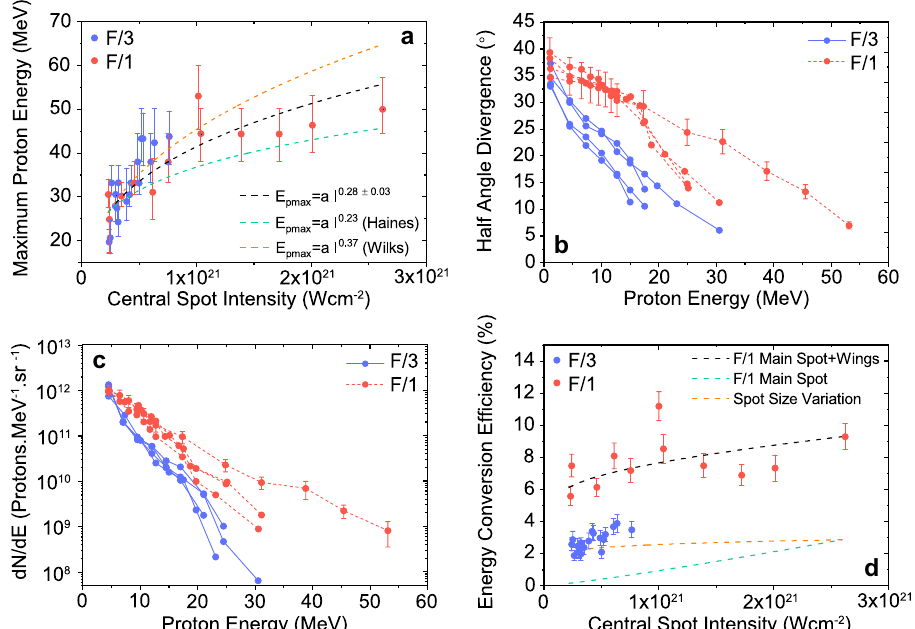
Figure 2. Measured proton beam properties for two different focusing geometries. ( a ) Maximum proton energy as a function of the central spot peak intensity ( I L ). The dashed black curve is a power law fit to the measurements. The orange and green dashed curves represent the E pmax scaling as modelled using the Mora 28 formulae with the hot electron temperature determined from the Wilks 29 and Haines 30 models, respectively. ( b ) Representative measurements of proton beam divergence as a function of energy. ( c ) Same for proton beam 20 energy spectra. In ( b ) and ( c ), the peak intensity in each focusing case is approximately equal ((3 ± 1) × 10 W cm − 2 ), with the exception of the highest E 10 21 W cm − 2 . The pmax F/1 data, for which the intensity was 1 × representative error bars are applicable to all of the data. ( d ) Laser-to-proton energy conversion efficiency as a function of I L . Results of a simple model of the efficiency scaling for three cases: (i) F/1 spot, including wings (dashed black); (ii) F/1 central spot only (dashed green); and (iii) varying central spot size (dashed orange). In all cases, 6 µ m-thick Al foil targets were irradiated. Each data point in ( a ) and ( d ) represents a single laser